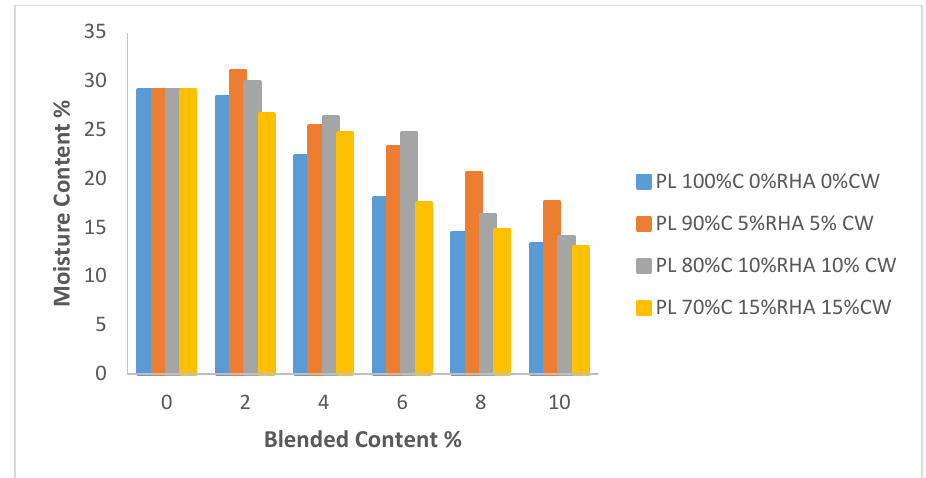
Fig. 3. Relationship between the PL of laterite treated with (100%C 0%RHA 0%CW), ( 90%C